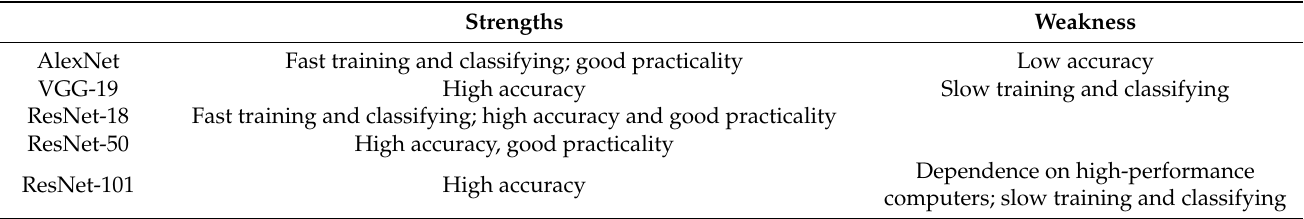
Table 5. Strengths and weaknesses of each trained model.